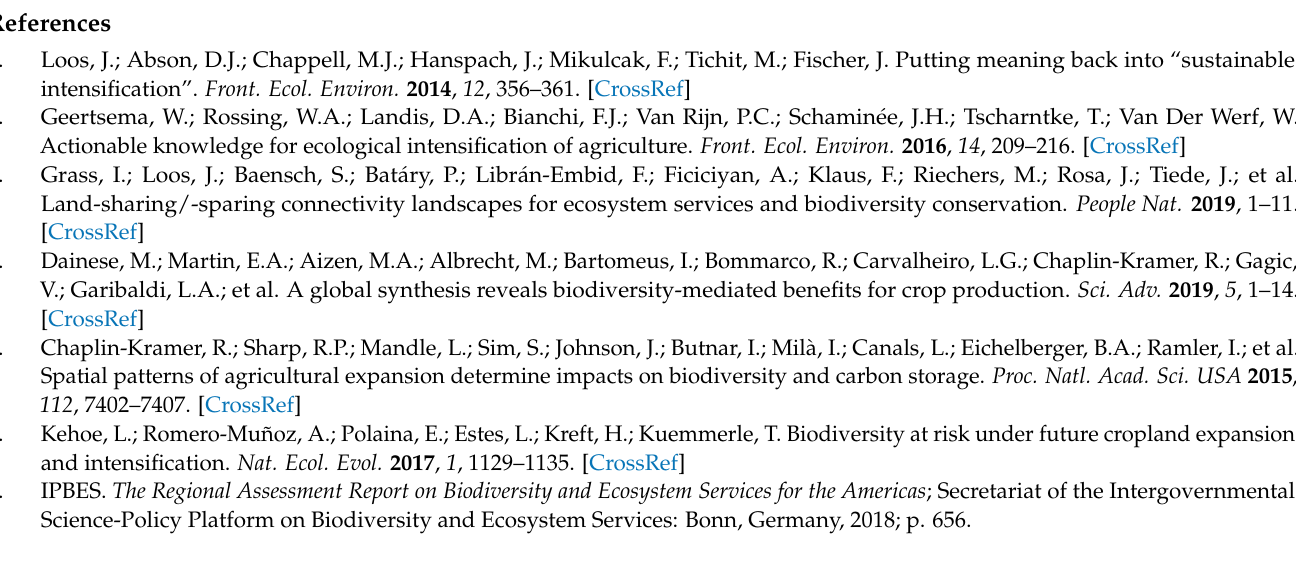
Figshare repository at